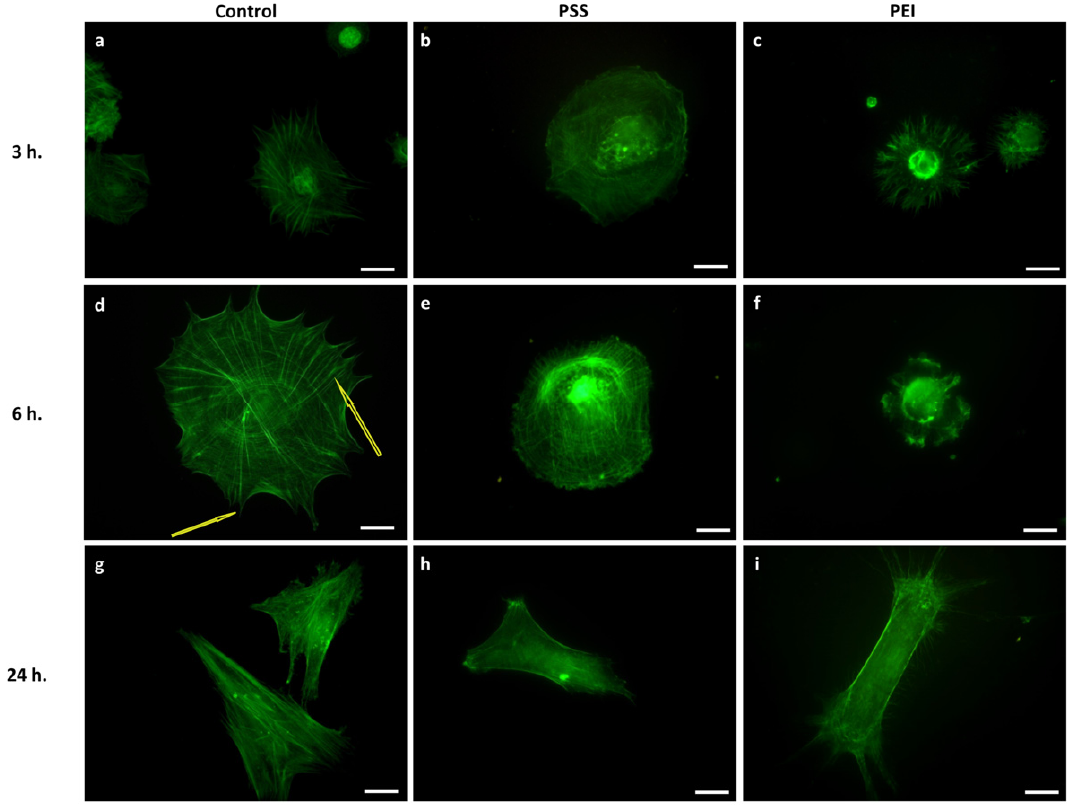
Figure 2. Representative images of the cytoskeleton structure of MSCs after 3 h, 6 h, and 24 h of culture time on glass slides ( a , d , g ), PSS-ended slides ( b , e , h ), and PEI-ended ( c , f , i ) slides. Green represents a FITC-phalloidin stain of the actin cytoskeleton. Scale bar: 5 µ m. Yellow arrows show stress fibers and filopodia formation.